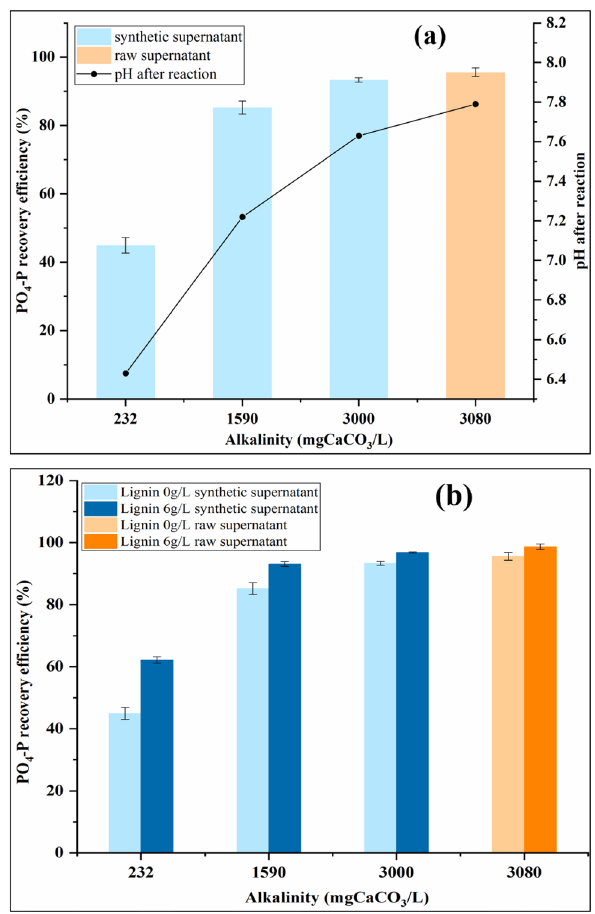
Figure 2. Impact of alkalinity on PO 4 –P recovery efficiency for ( a ) without lignin addition, pH was measured after reaction, ( b ) with lignin addition (synthetic supernatant: initial pH = 7.9, Mg/P molar ratio =